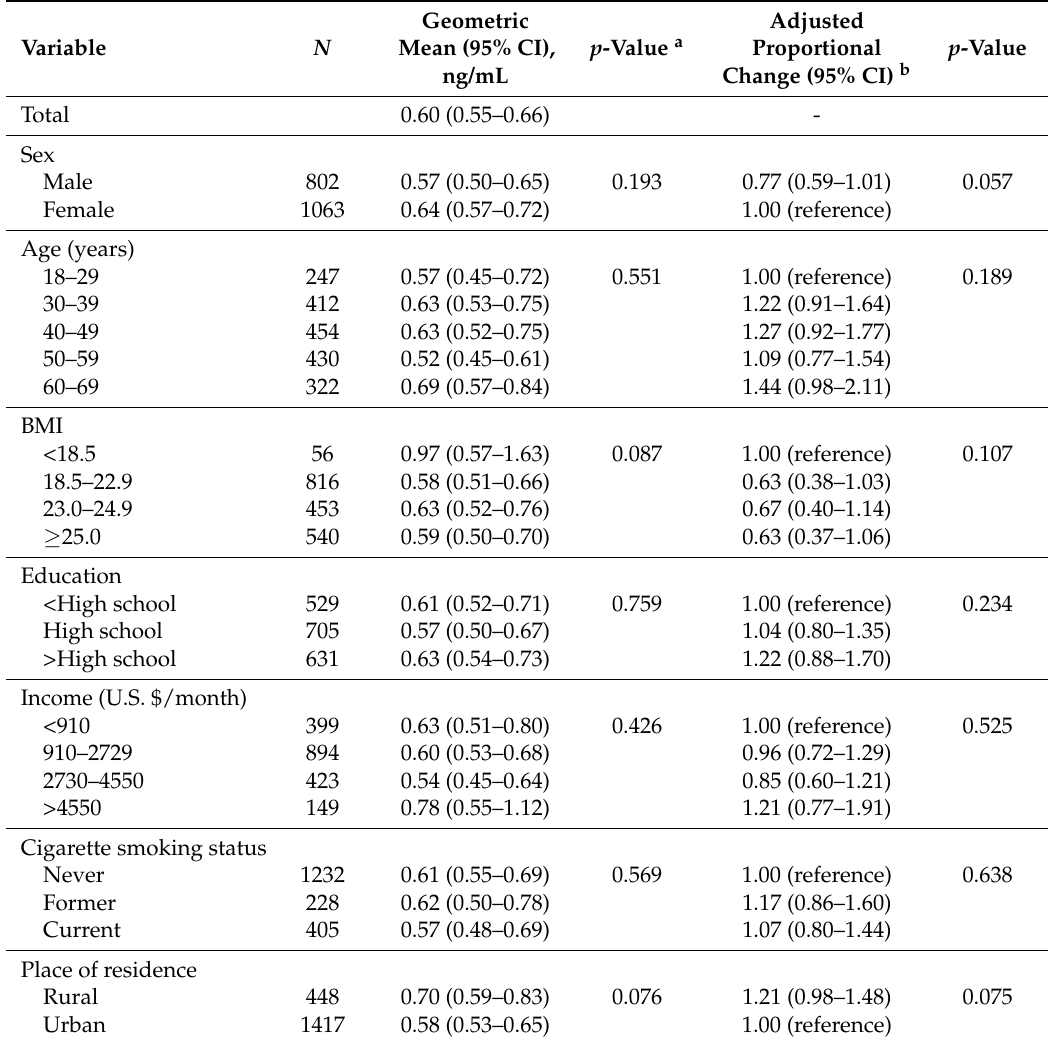
Table 5. Population-weighted geometric means and adjusted proportional changes in urinary 4-t-octylphenol concentrations by demographic characteristics in the Korean population aged 18–69